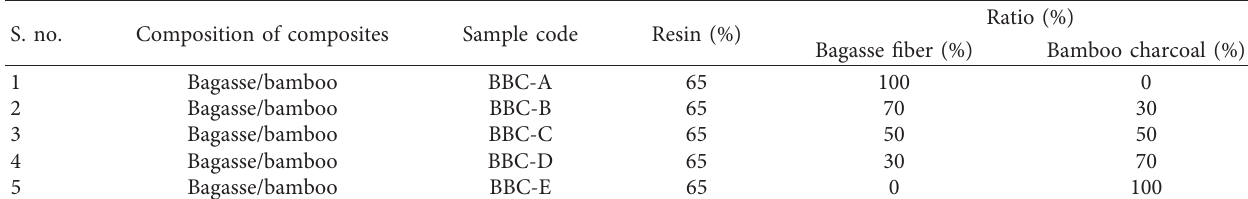
Table 1: Composition of prepared samples.